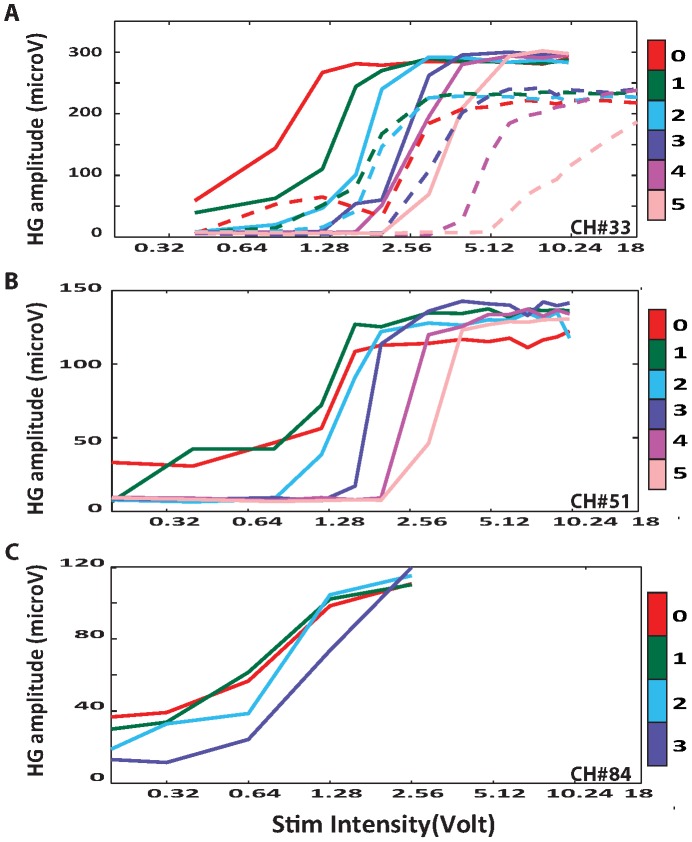
Distance-Voltage-Response summary.Single channel high-gamma band response summary showing variations by voltage and distance for Sheep 1 (A), Sheep 2 (B), and Sheep 4 (C). Solid color lines represent intradural SC stimulation while dashed lines represent epidural stimulation. Traces are color coded according to the distance of the SC stimulator from the pial surface (color bar). The y-axis denotes High-Gamma (HG) response amplitude while the x-axis denotes the stimulation voltage (log spacing).